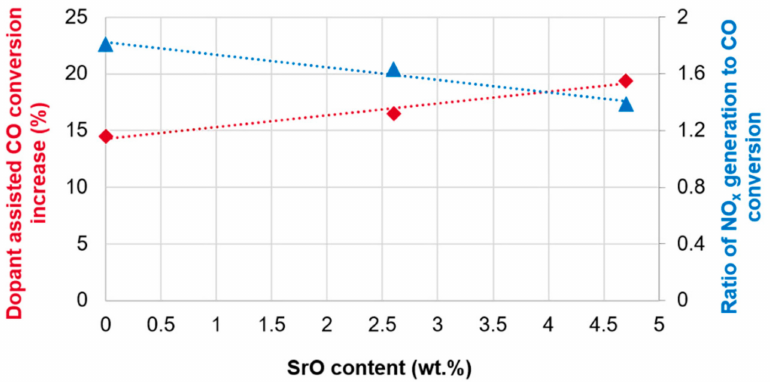
Figure 4. The dopant-assisted CO conversion as well as the ratio of NO x generation to CO conversion are reported as a function of promoter SrO content. The color-coding is reported in the plot alongside with fitted curves exemplifying the discussed trends. Catalysts were tested by mixing 99% spent FCC catalyst and 1% fresh promoter using a plug flow reactor operating at 1 L/min flow rate with a feed of 2 vol.% O 2 in N 2 at 700 ◦ C. The emissions values determined by comparing to a promoter-free base case experiment. The method used to calculate CO conversion and NO x generation is reported in the experimental